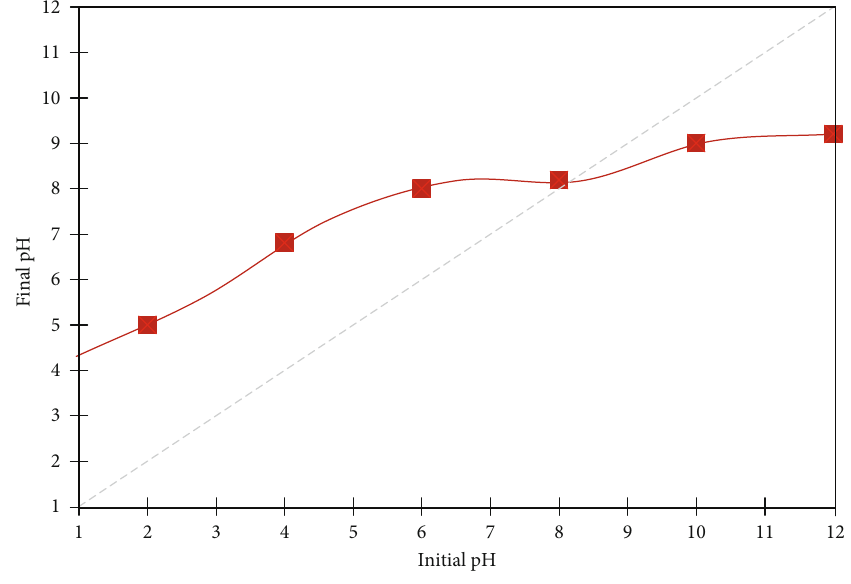
Figure 2: Plot of the pH drift